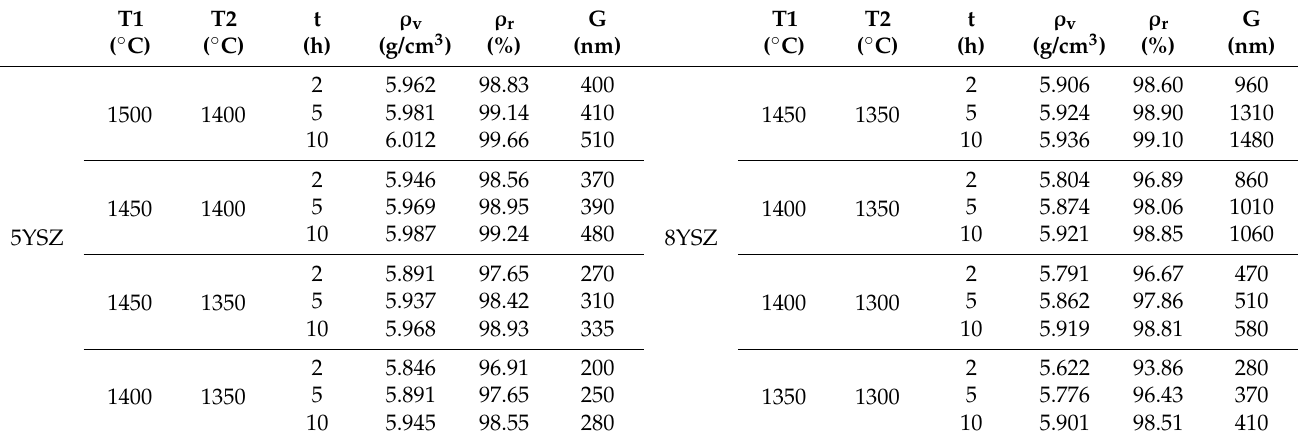
Figure 4. Schematic representation of Arrhenius plot for sintering mechanisms [30,34] (1 — Surface diffusion mechanism; 2 — body diffusion mechanism; 3 — evaporation and accumulation mechanism; 4 — grain boundary diffusion mechanism; 5 — Grain boundary migration mechanism; 6 — Intersection migration mechanism). Table 1. Sintered densities and grain size of 5YSZ and 8YSZ ceramics under various heating parame- ters of two-step